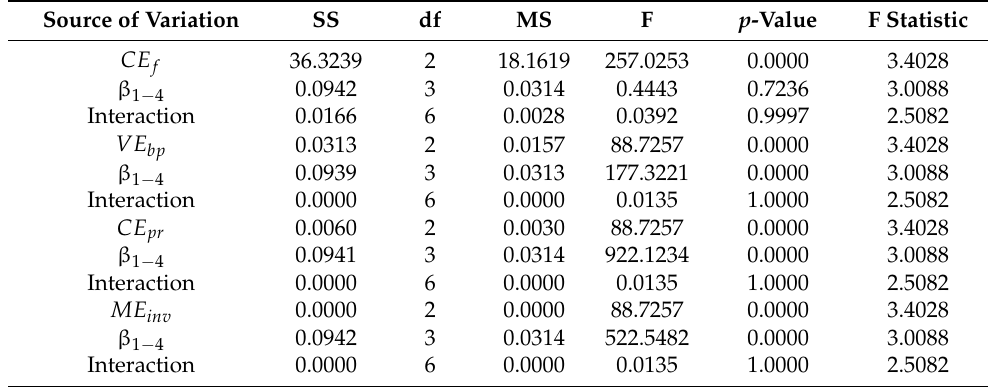
Table 2. ANOVA indicators for the influence of factors proposed in financial competitiveness model (fragment, company A).